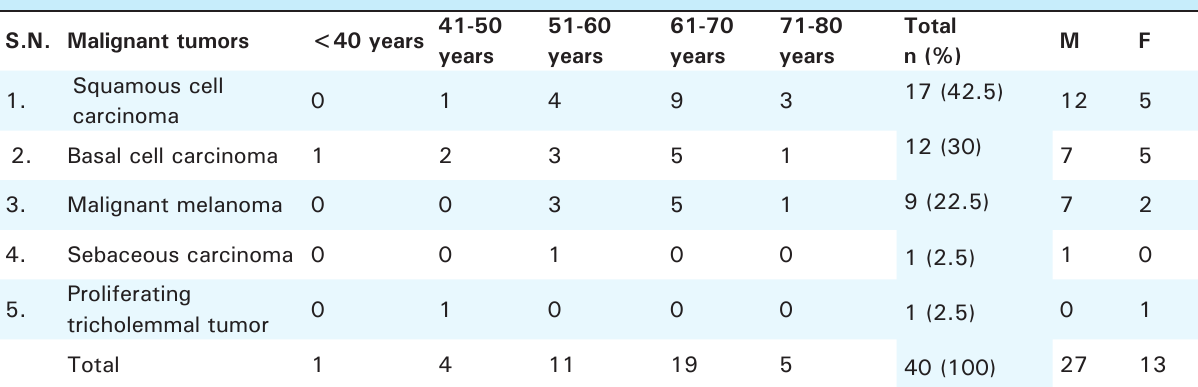
Table 2. Age and gender distribution of Malignant tumors (n=40). S.N. Malignant tumors